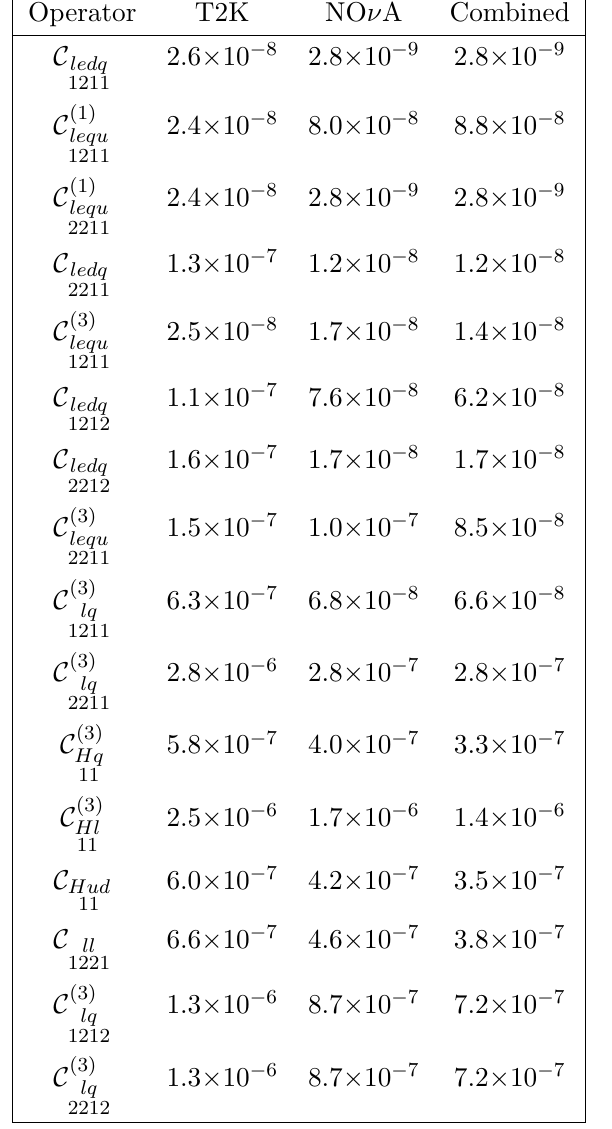
Table 6 . Upper bounds on the Wilson coefficient C as obtained from the long-baseline neutrino experiment data. The constraints are provided in units of TeV at 95% CL significance for T2K and NO ν A, both individually and